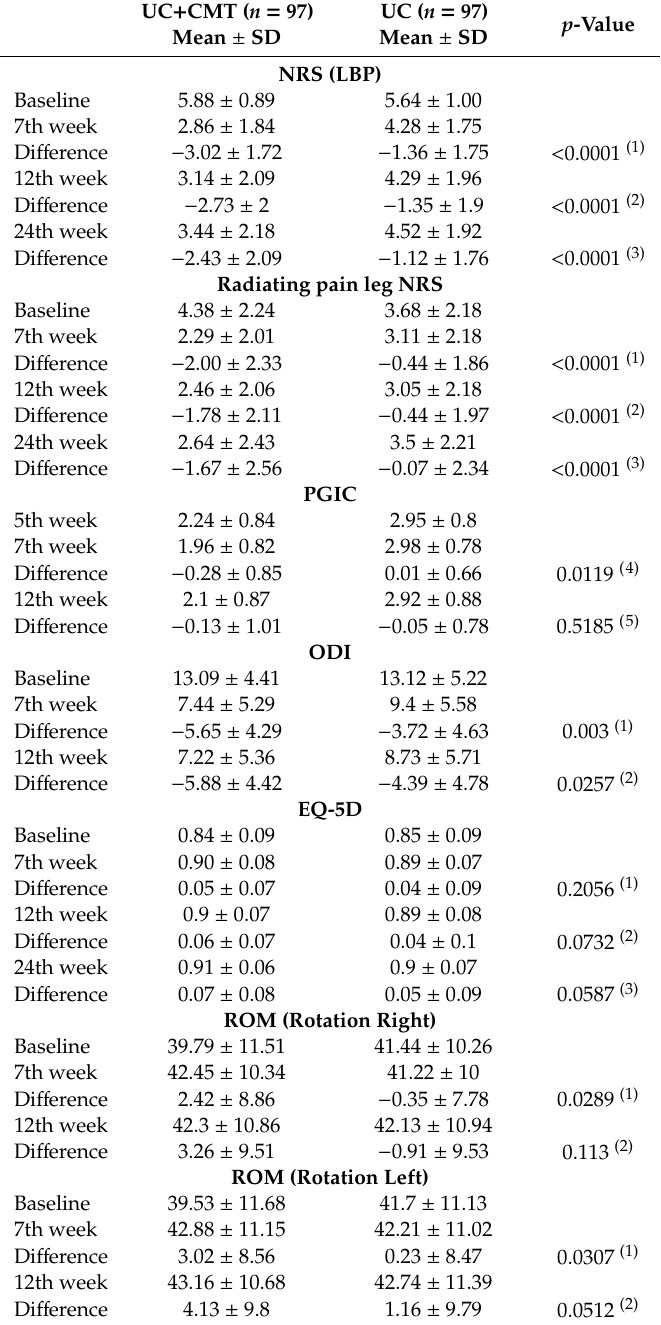
Table 2. Mean di ff erences for usual care alone versus usual care plus CMT on primary outcome secondary outcome variables at each assessment